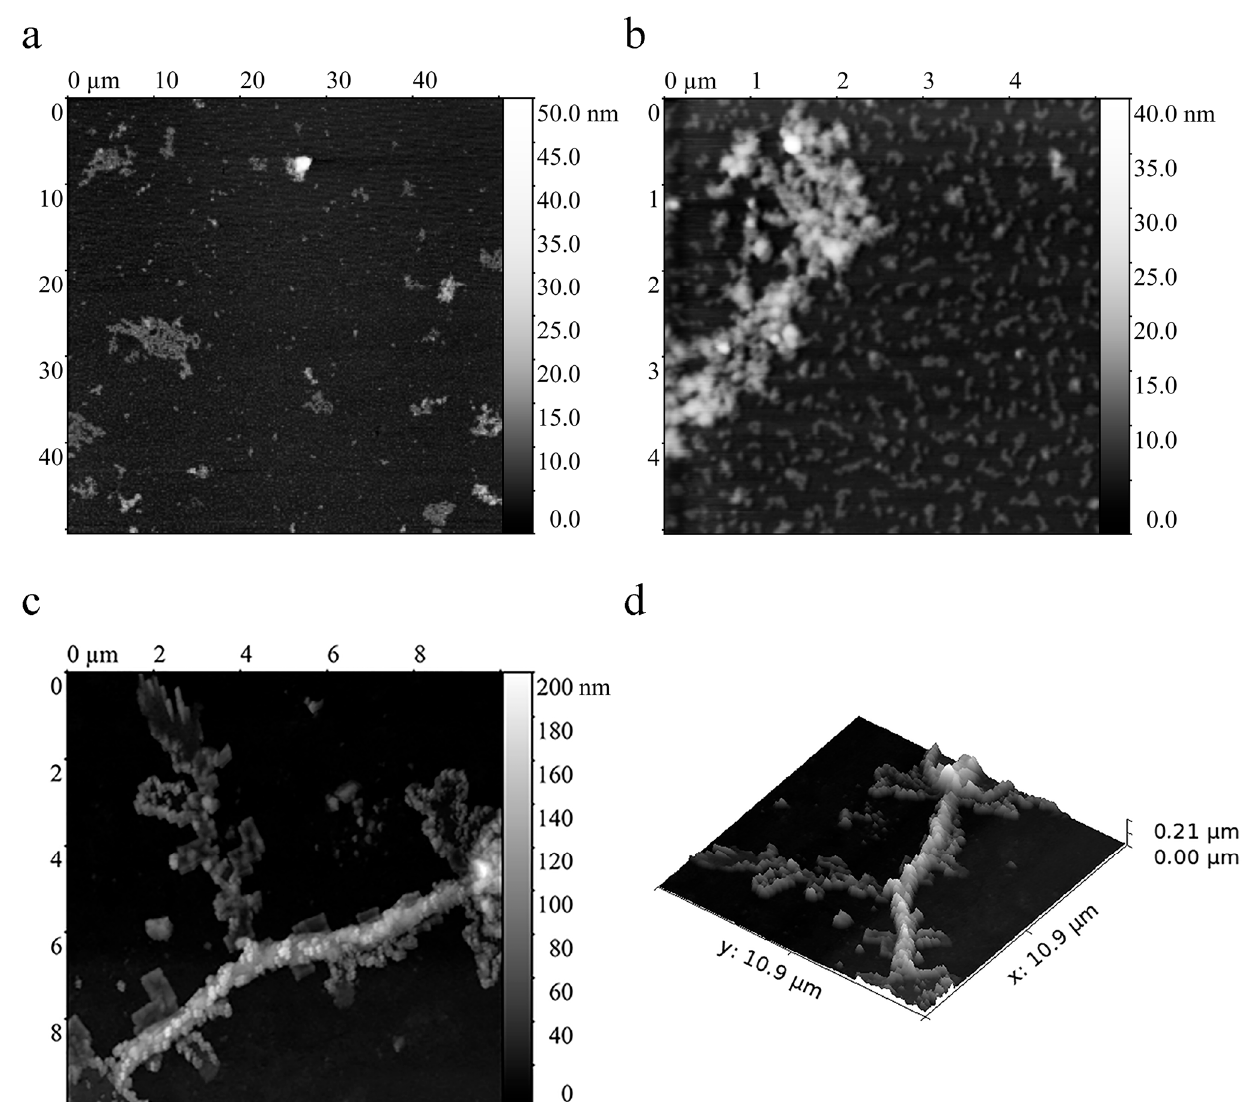
Figure 5. Atomic force microscopy of sMyBP-C aggregates formed after 24 h of incubation. ( a , b ) Large aggregates ~2 up to ~10 µ m in size and up to 7–15 nm in height; ( b ) smaller aggregates shaped as extended structures up to 200 nm long ~50–60 nm wide and spherical structures ~50 nm in diameter. The height of these aggregates is from 10 up to 15 nm. ( c , d ) Large extended structures ~100 nm high and ~100 nm wide. The original images are at: https://drive.google.com/